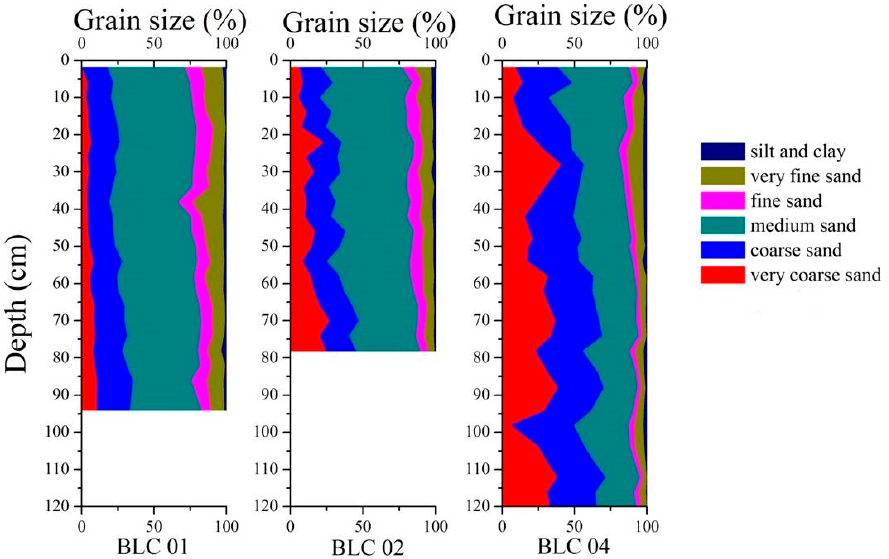
Figure 4. Grain size distribution of sediment cores obtained from Batticaloa lagoon.